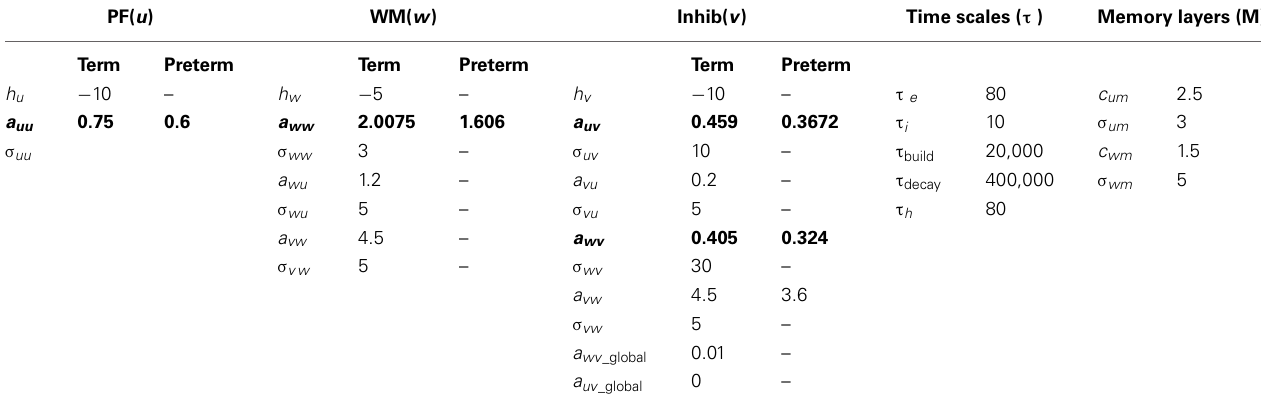
Table A2 | Neurocognitive system parameters.